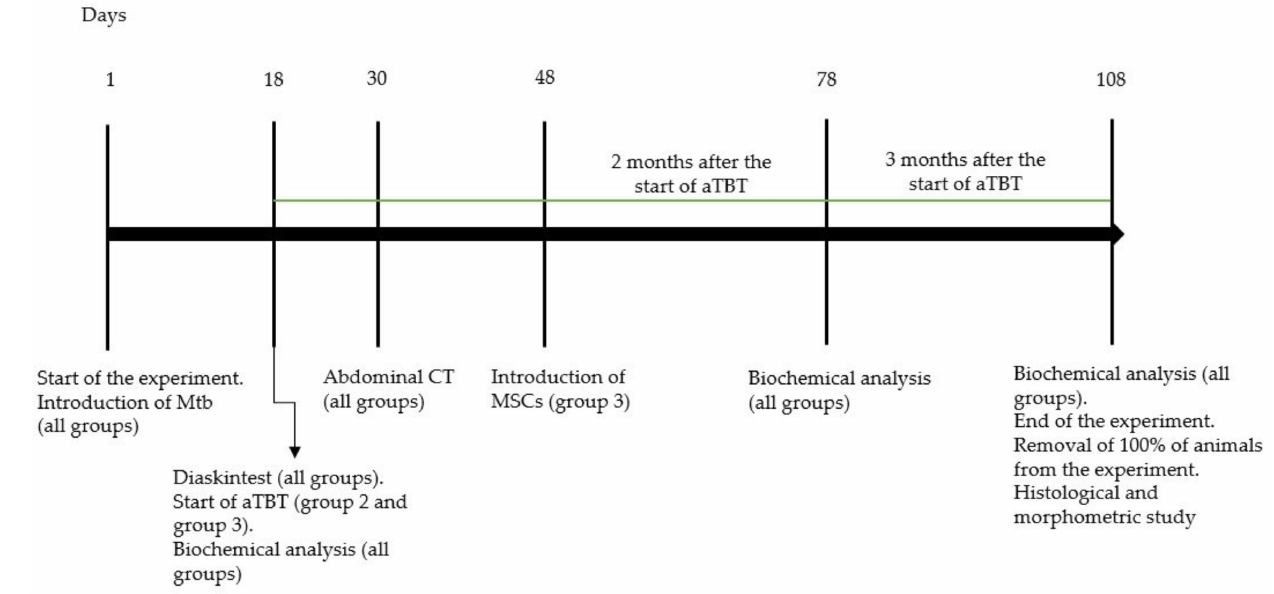
Figure 1. Experimental study design. Abbreviations: Mtb—M. tuberculosis. CT—computed